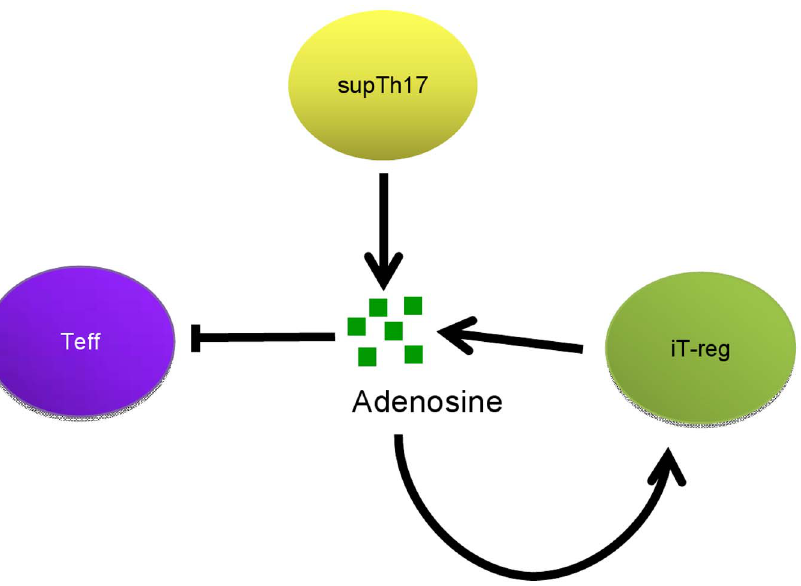
Figure 8. SupTh17, iT-reg and purinergic control of T-cell immune responses. Both supTh17 and iT-reg cells have the capacity to suppress effector T-cells (Teff) by generating adenosine. In a manner distinct from iT-reg which are anergic, however, supTh17 express low levels of A2A receptor and exhibit nucleoside scavenging ecto-enzymatic activity. These properties confer on supTh17 an important intrinsic resistance to suppressive effects of adenosine, which may develop in parallel with prolonged cellular activation in accordance with memory T-cell status. These differences suggest that supTh17 might undergo conversion and be recruited as suppressor-type cells in the later evolution of immune responses where these cells may persist at sites of resolving